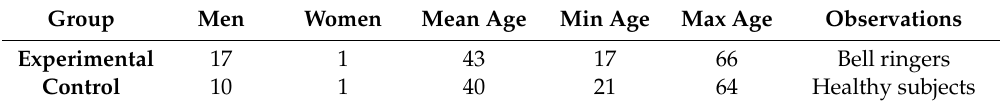
Table 4. Characteristics of the